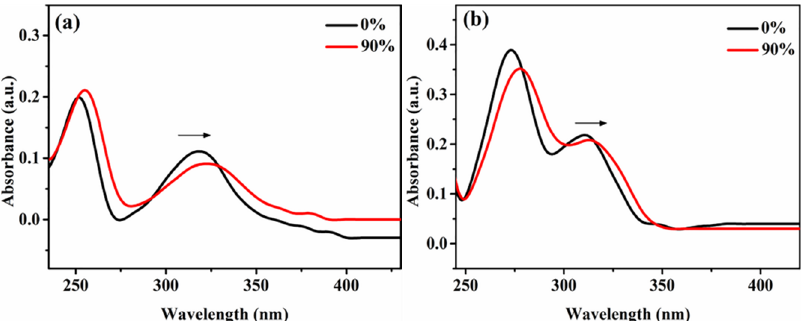
Figure 2. UV-vis absorption spectra of compounds mixed solution with water fraction changing from 0 to 90% ( a ) 1 , ( b ) 2 .